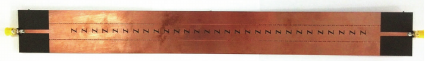
Figure 8: Photograph of the SIW with N-shaped slots.